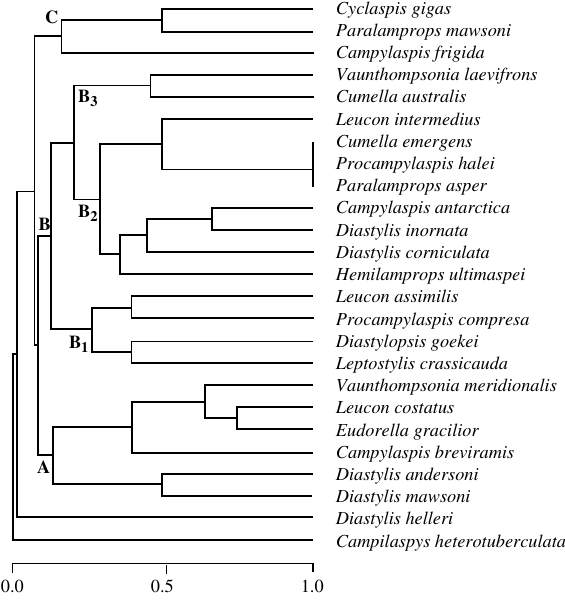
F IG . 12. – Dendrogram of similarities (using Jaccard’s index and UPGMA aggregation algorithm) between the 25 cumacean species collected during BENTART-95